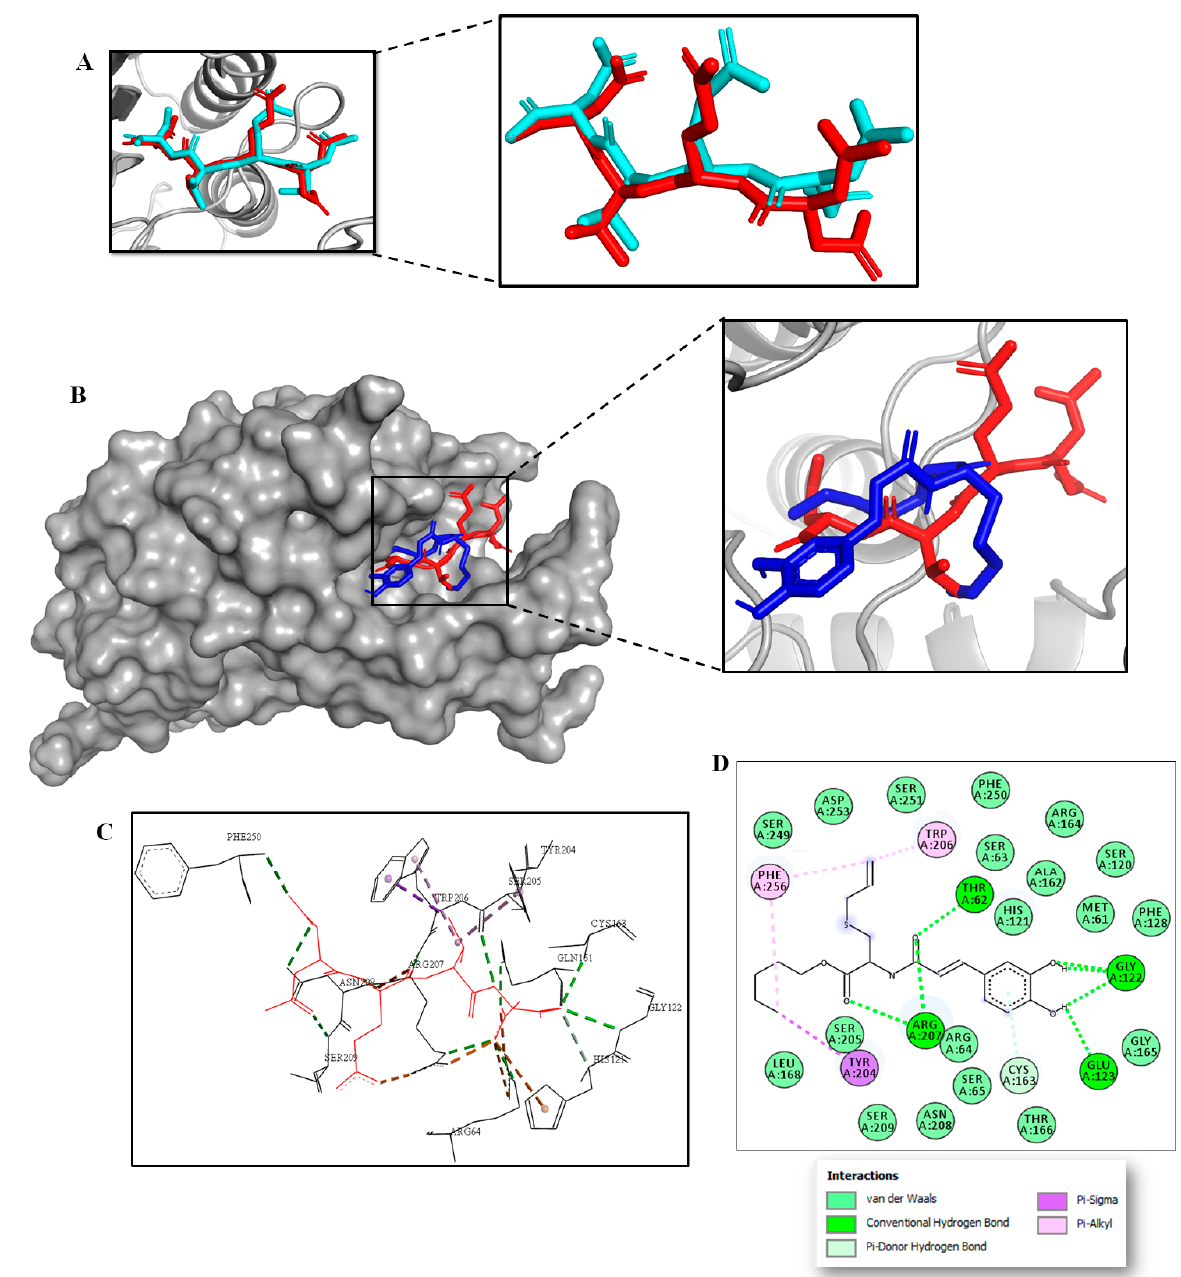
Figure 6. ( A ) Self-docking validation: alignment of the best-docked pose of Ac-DEVD-CMK (in cyan ) and the crystallographic binding mode (in red). ( B ) Superposition of the best-docked conformation of the hybrid SAC-CAFA-PENT (blue), and crystallographic binding mode of the inhibitor Ac-DEVD-CMK (red), within the caspase-3 binding domain. ( C ) Binding interactions of the co-crystallized Ac-DEVD-CMK within the caspase-3 binding domain. ( D ) 2D protein–ligand interaction plot after the docking procedure for SAC-CAFA-PENT. Dashed lines represent H bonds and π contacts.